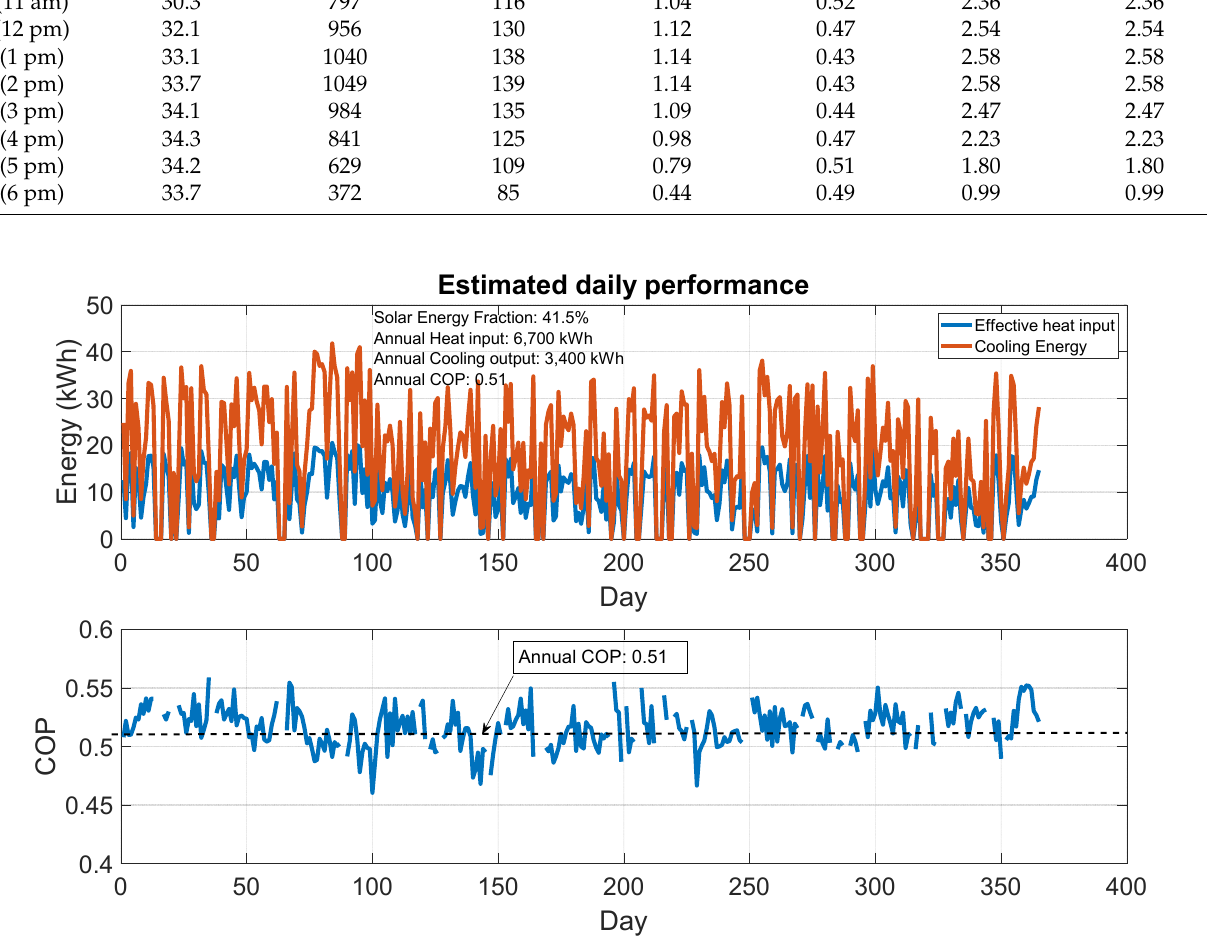
Figure 9. Examples of hourly daily cooling production (1 January and 5 April). 5. Conclusions The design of an adsorption air conditioning system using activated carbon–methanol as the working pair has been investigated for potential use in Singapore. A detailed and rigorous system design methodology is described. It includes: 1.